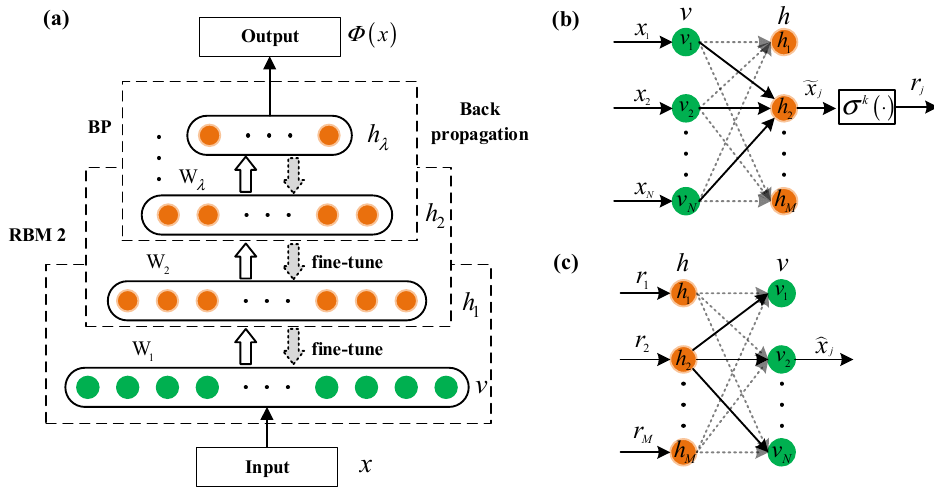
Figure 1. ( a ) The structure of DBN, which can be approximated as a stack of RBMs. ( b ) The feedforward architecture of the j -th hidden neuron. ( c ) The reconstruction architecture of the j -th hidden neuron.